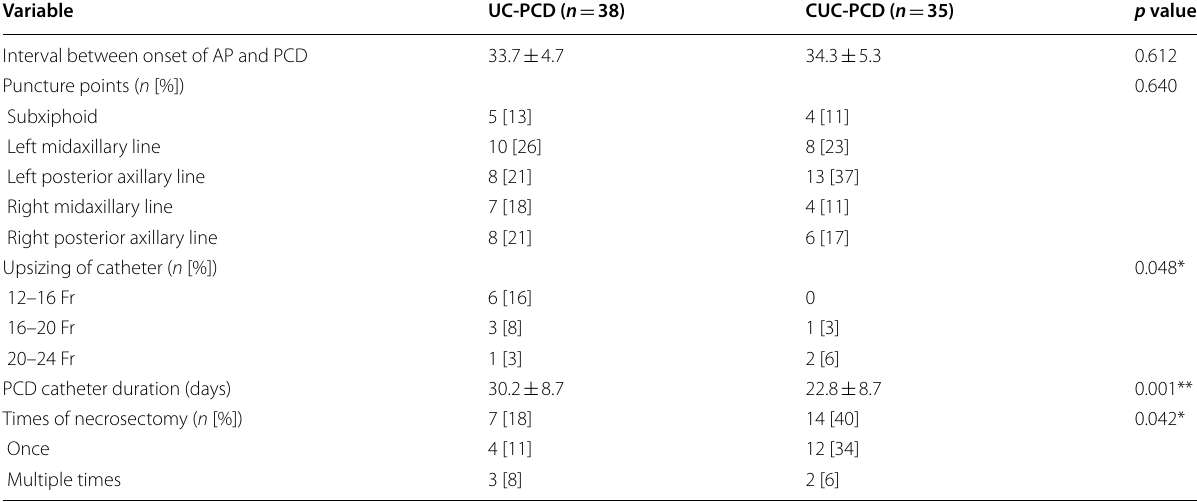
PCD, percutaneous catheter drainage * p < 0.05, ** p < 0.01